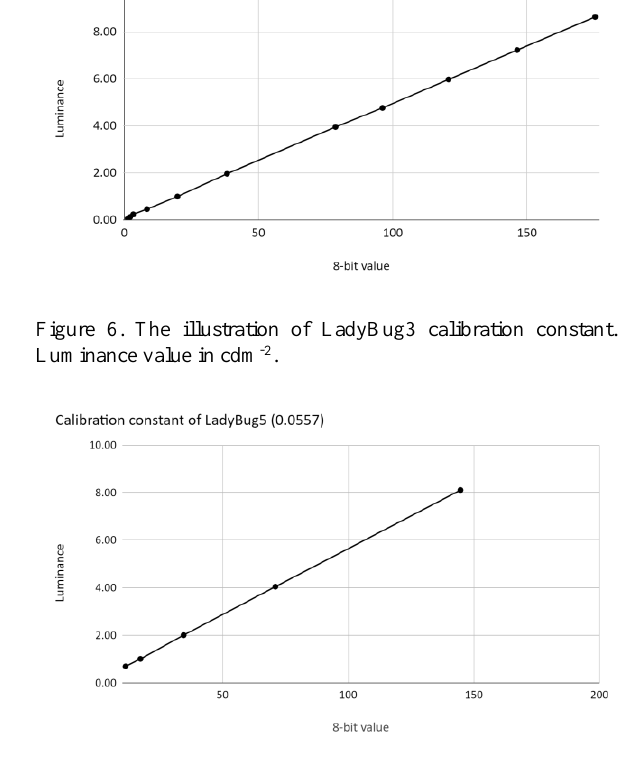
Figure 7. The illustration of LadyBug5 calibration